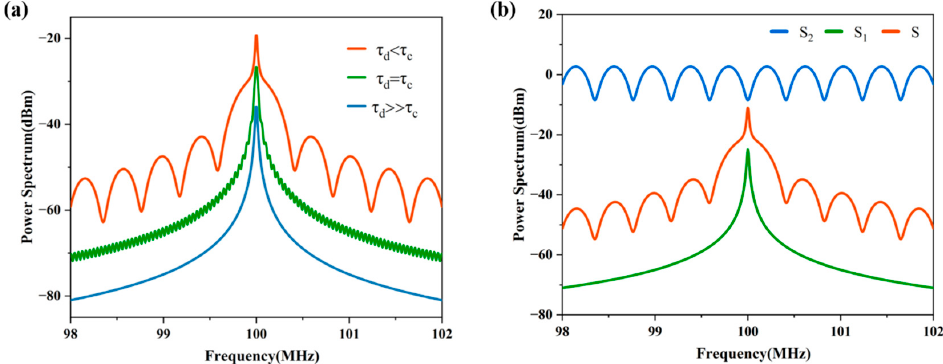
Figure 2. Theoretical plots of the PSD from a delayed self − heterodyne measurement setup showing the effects of different delay times ( a ) and the line shapes of S 1 , S 2 , and S ( b ). Current methods which are used to extract the laser linewidth from the PSD envelope